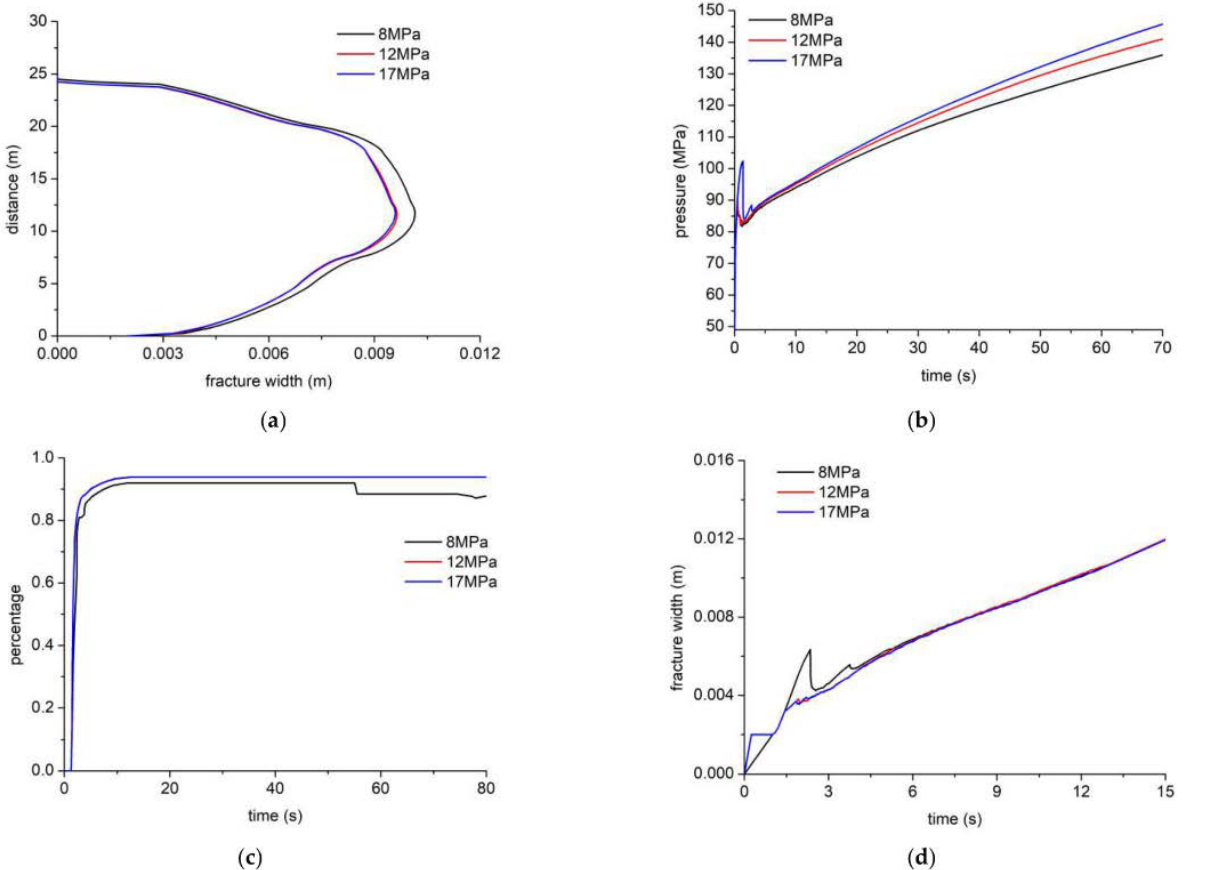
Figure 11. Fracture parameter under different cohesion levels: ( a ) HF width; ( b ) pressure; ( c ) ratio of tensile failure; and ( d ) maximum HF